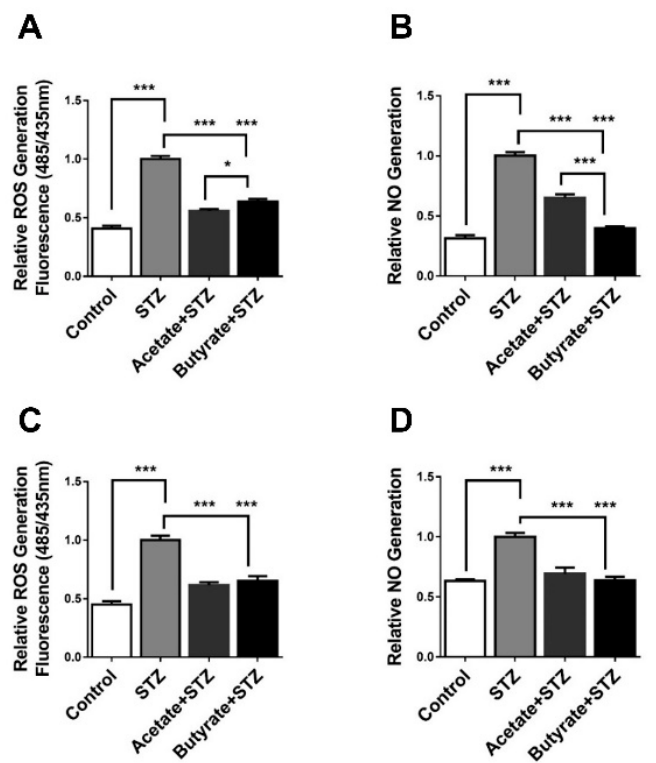
Figure 6. Effects of acetate and butyrate on STZ-induced free radical generation in human islets and MIN6-cells. Human islets ( A , B ) and MIN6-cells ( C , D ) were incubated with 1 mM acetate or butyrate for 1 h followed by 24 h incubation with 5 mM STZ. Intracellular reactive oxygen species (ROS) was measured with a 2 ′ ,7 ′ -dichlorofluorescin diacetate ( DCFDA) Cellular ROS Detection Assay Kit ( A , C ). The fluorescence signal was monitored at Ex/Em = 485/535 nm. Nitric oxide (NO) was detected using a Nitric Oxide Assay Kit ( B , D ). Results represent mean ± SEM ( n = 5). The statistical differences were quantified using one-way ANOVA analysis with Newman–Keuls multiple comparisons test (* p < 0.5, *** p < 0.001).